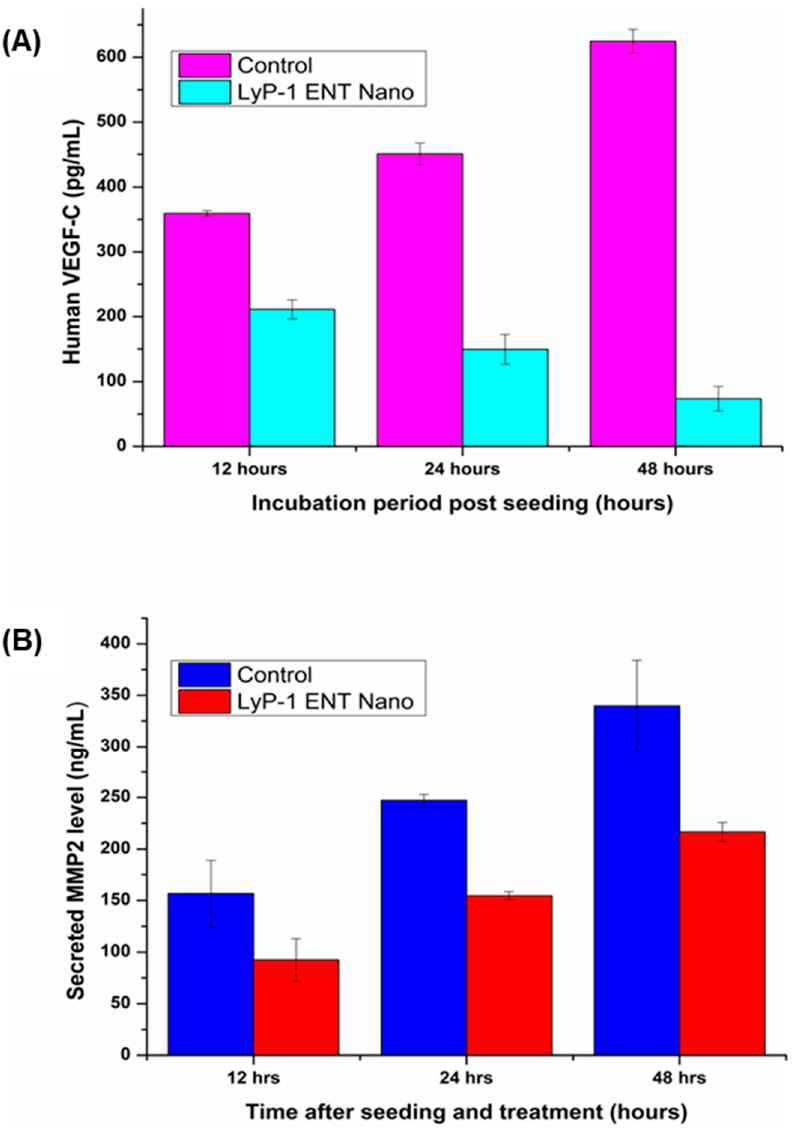
Figure 9. Anti-angiogenic assessment of functionalized LyP-1 nanoparticles. ( A ) VEGF-C expression in SCC KYSE-30 cells under cell culture conditions. KYSE-30 cells in culture conditions were washed with PBS and cultured in fresh medium without FBS as control. The LyP-1-functionalized ENT-loaded nanosystem was dissolved in free FBS culture media (2.5 mg/mL) as the treatment group. Culture supernatants were harvested at 12, 24 and 48 hours post-treatment by ELISA assay. Concentration of VEGF in supernatants was represented as pg/mL in duplicate. ( B ) Effects of ENT on MMP-2 production by KYSE-30 cells. KYSE-30 cells (80% confluent, in a 75 cm 2 flask) were incubated with the LyP-1-functionalized ENT-loaded nanosystem for 48 h (each at 2.5 mg/mL). Untreated KYSE-30 cells were used as the control. Cell supernatants were harvested for MMP2 assay by ELISA. Samples were prepared in duplicate. Error bars indicate ± standard deviation.